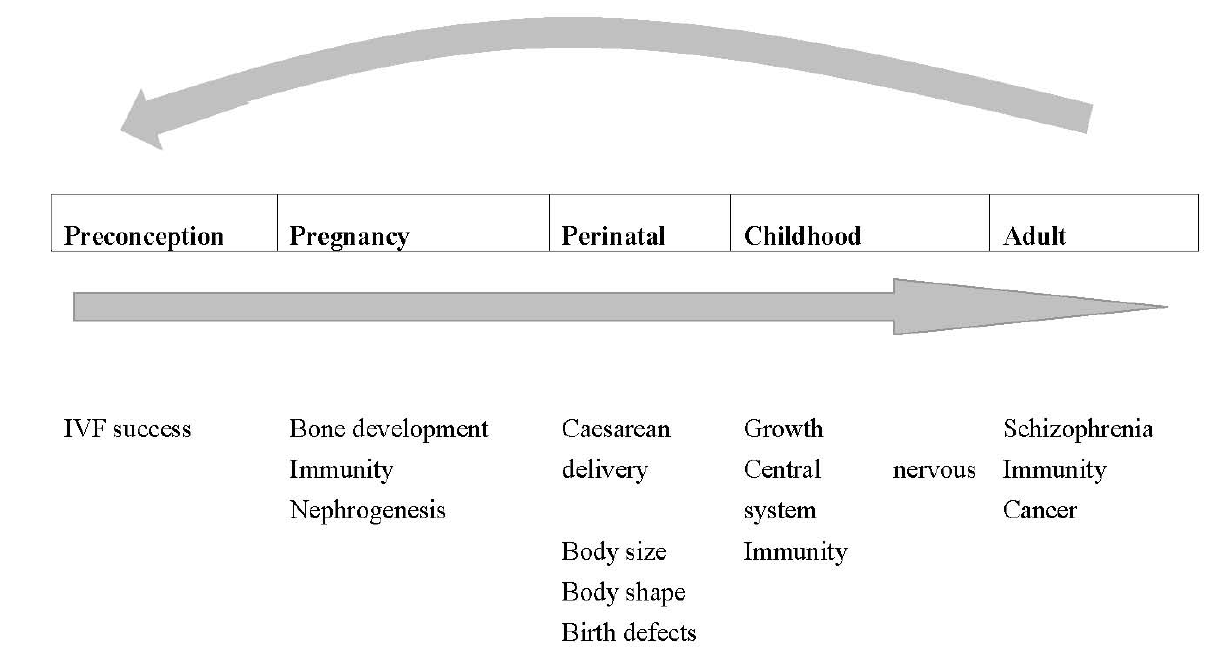
Figure 1. Manifestation of reviewed possible major outcomes related to vitamin D status at different life